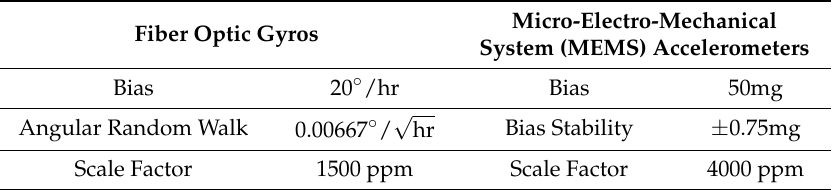
Table 1. Performance specifications of